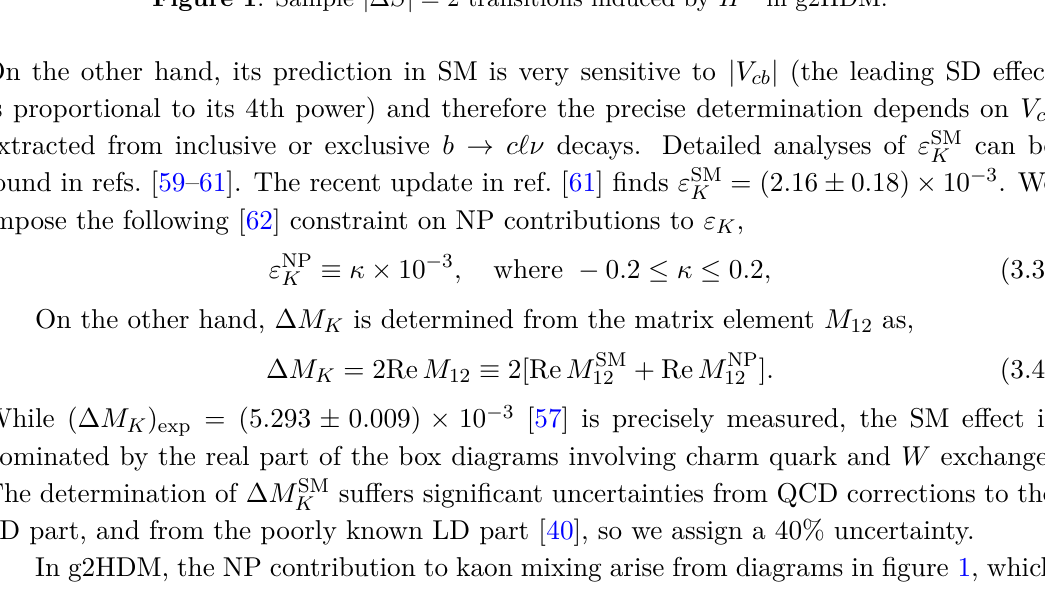
Figure 1 . Sample | ∆ S | = 2 transitions induced by H − in